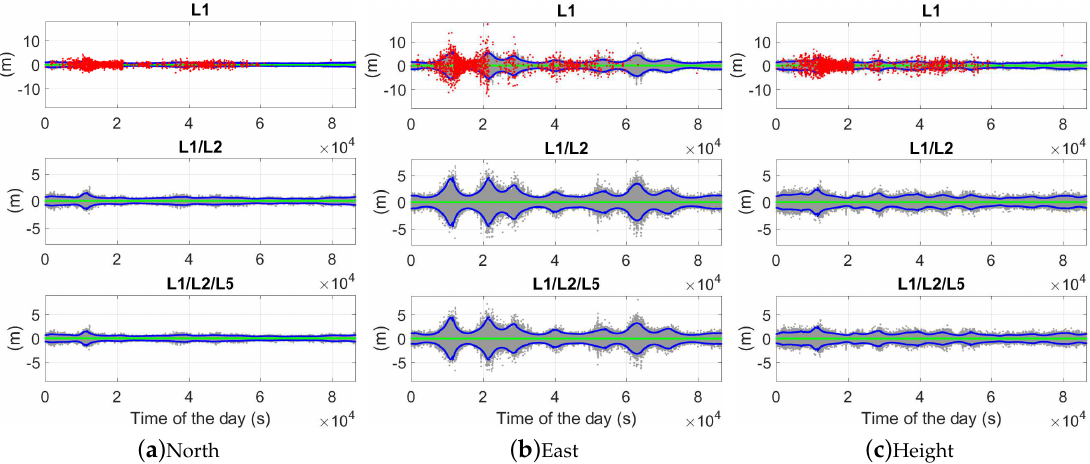
Figure 10. Baseline errors for CUAA-CUBB in the phase-only two-epoch case. The time span between the two epochs is 30 s. The gray, green, and red dots represent the ambiguity-float, -correctly-fixed, and -wrongly-fixed solutions, and the blue dots represent the 95% formal confidence intervals of the ambiguity-float solutions. Note that the scales in different sub-figures are